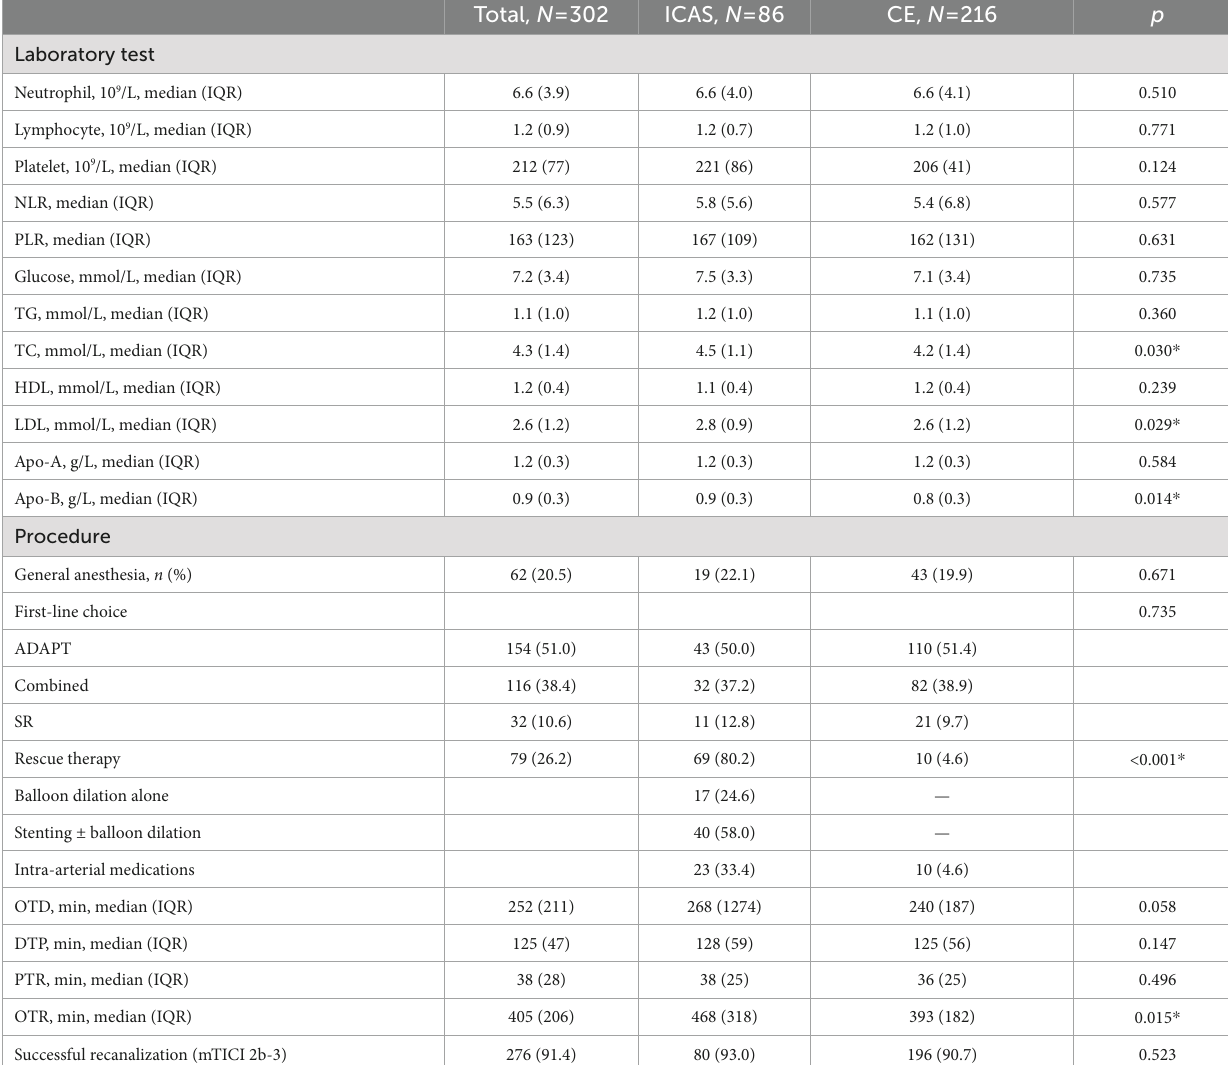
TABLE 2 Comparison of laboratory test and procedural information between two